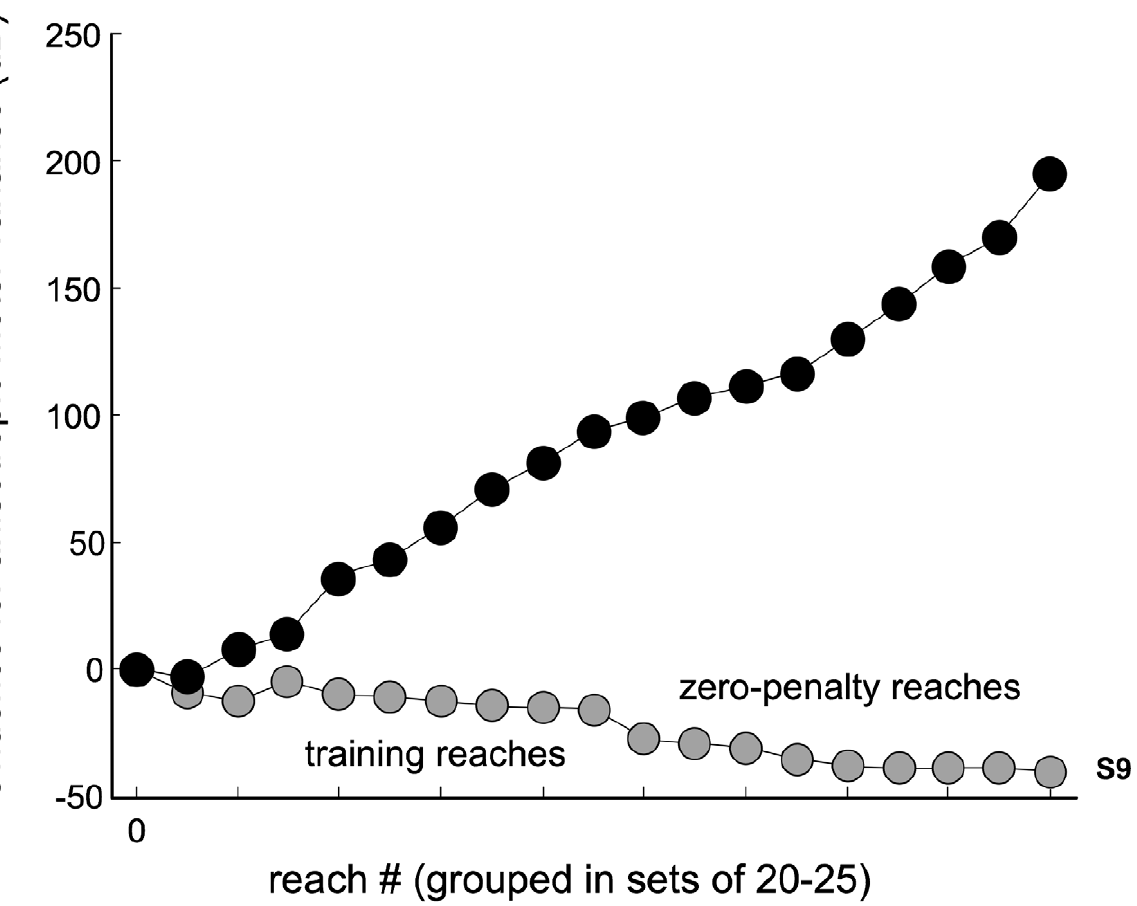
Figure 6. Evidence for anisotropic noise. During the drift session, reaches were perturbed by the manual following response. Evidence values quantify the information available to subjects signifying that the variance along the x-direction is greater than in the orthogonal direction (as opposed to being equal). Positive values are evidence in favor of the indicated anisotropy, and negative values are evidence in favor of equal variances. Each subject is plotted separately. By the end of the training portion of the drift session, the evidence overwhelmingly indicates that motor noise has become anisotropic (for S1–S8). Evidence in favor of this hypothesis continues to accumulate over the course of the session. Note that larger positive values indicate stronger evidence in favor of anisotropic variances, and not a larger anisotropy. That is, evidence values increase as more data consistent with the hypothesis of anisotropic variances becomes available (i.e., due to the increase of the size of the dataset with an increasing number of trials).